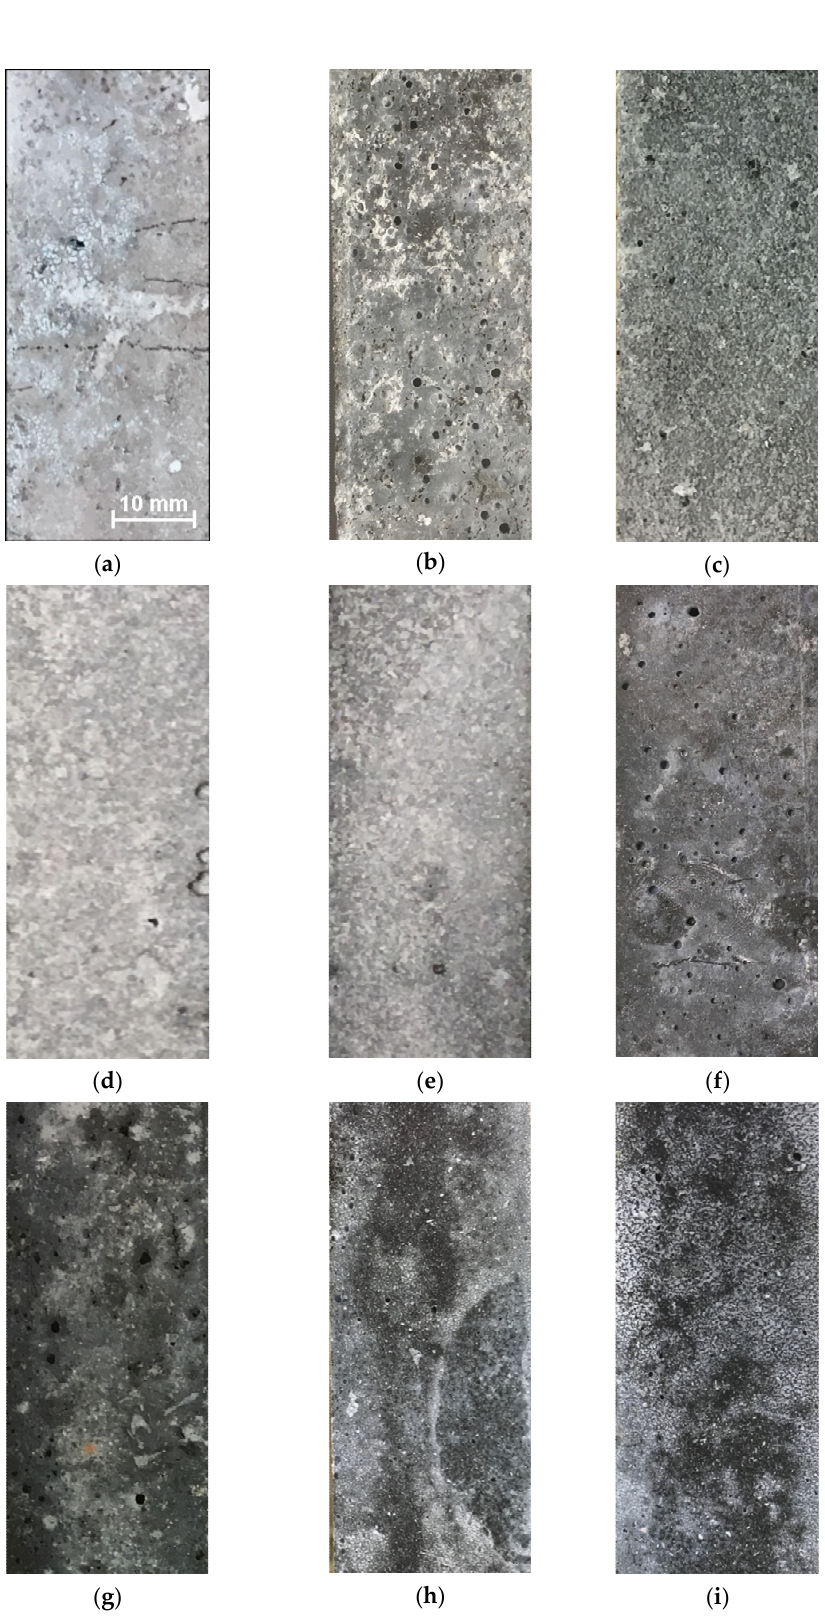
Figure 1. Samples surfaces after ASR testing process according to ASTM C1260 (2020/2021): ( a ) REF HPC; ( b ) GPP HPC 50%; ( c ) GPP HPC 100%; ( d ) CWG HPC 50%; ( e ) CWG HPC 100%; ( f ) SGP HPC 50%; ( g ) SGP HPC 100%; ( h ) SGJ HPC 50%; ( i ) SGJ HPC 100%.